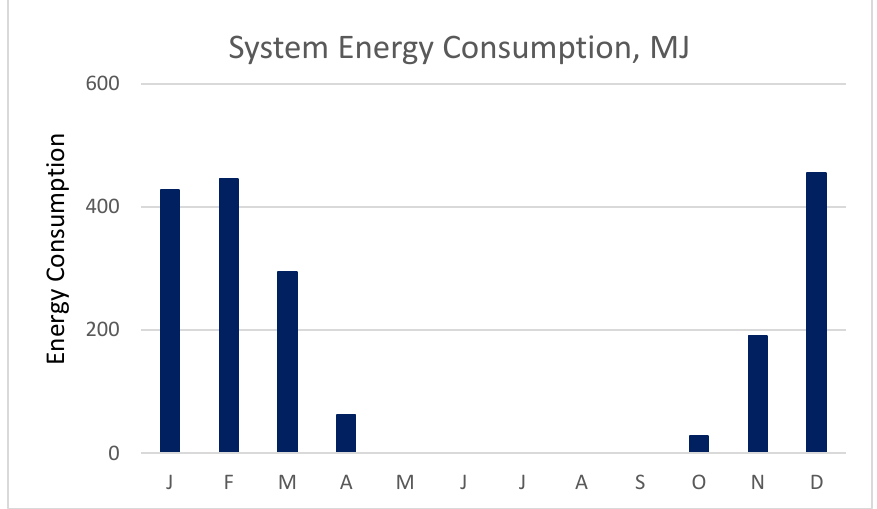
Figure 16. Electrical-energy consumption of the cooling system during economy-cycle mode.